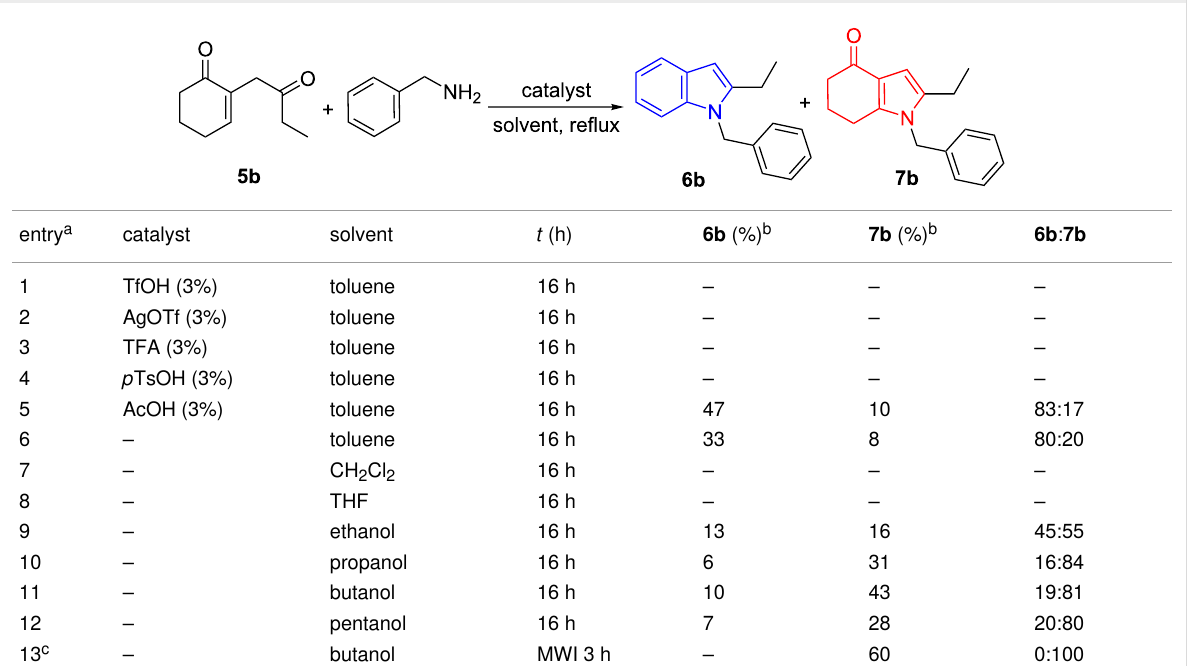
Table 1: Effects of solvent and heating mode on the 6b : 7b